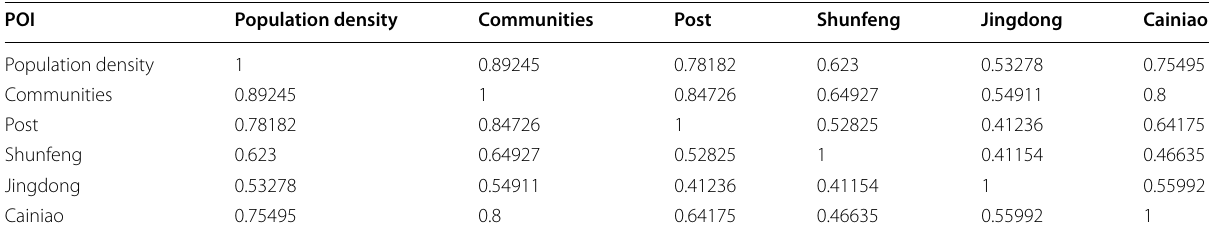
Table 3 The number of POIs covered by express logistics terminals at different distances Distance(m) 100 200 Covered POIs